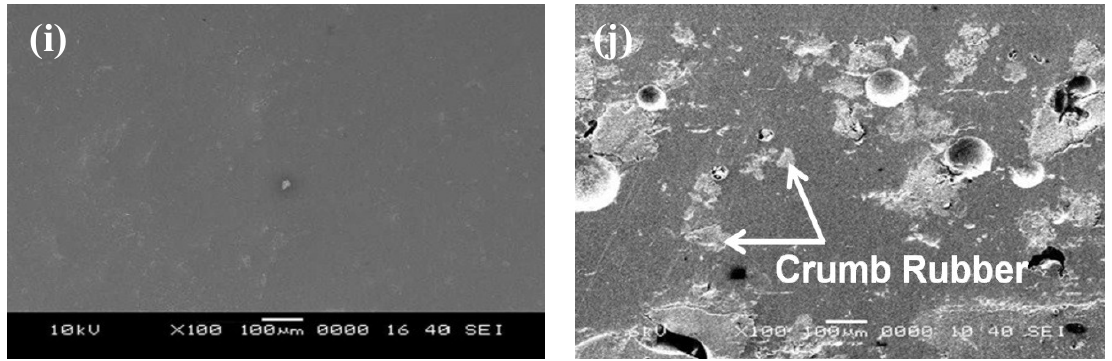
Figure 2. SEM images of the coatings with different compositions of CR: ( a ) top and ( b ) cross-sectional views of a coating made using 35% coarse particles; ( c ) top and ( d ) cross-sectional views of a coating made using 35% fine particles; ( e ) top and ( f ) cross-sectional views of a coating made using 35% coarse/fine particles at 1:1 ratio; ( g ) top and ( h ) cross-sectional views of a coating made using 35% coarse/fine particles at 4:1 ratio; ( i ) top and ( j ) cross-sectional views of a coating made using 35% coarse/fine particles at 1:4